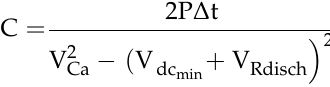
Figure 2. DC-link during compensation (discharge).